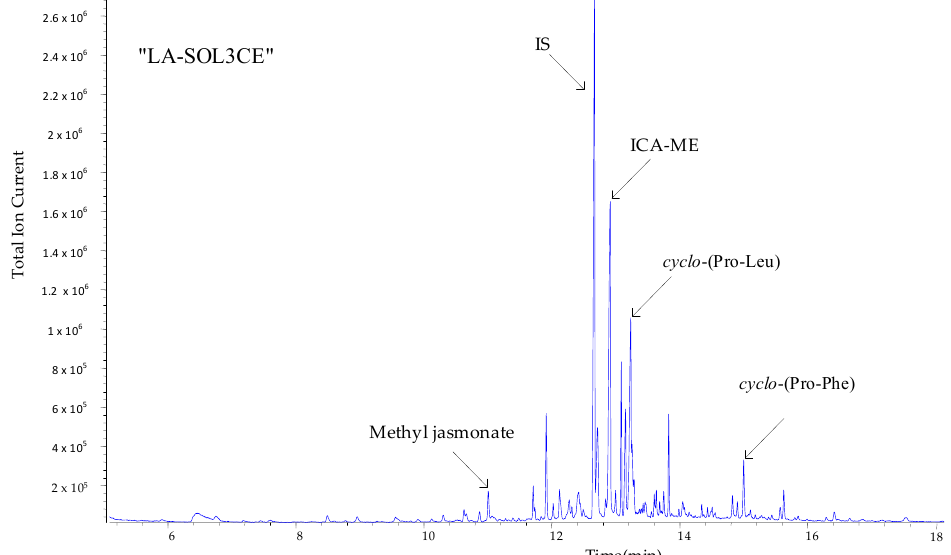
Figure 5. Annotated total ion chromatograms (TICs) acquired by processing crude extract of Lasiodiplodia theobromae LA-SOL3 (LA-SOL3CE) after derivatization with diazomethane in ether. A well-developed peak appears in the total ion chromatograms (TIC) of all crude extracts (at retention time ~12.5 min), which is easily attributed, from the associated mass spectrum (Figure S3 (Supplementary Materials)), to indole-3-carboxylic acid methyl derivative (ICA-ME). On the basis of this fact, ICA appears as the most suitable pilot metabolite to map quantitative differences that might exist in metabolites production when the two L. theobromae strains are